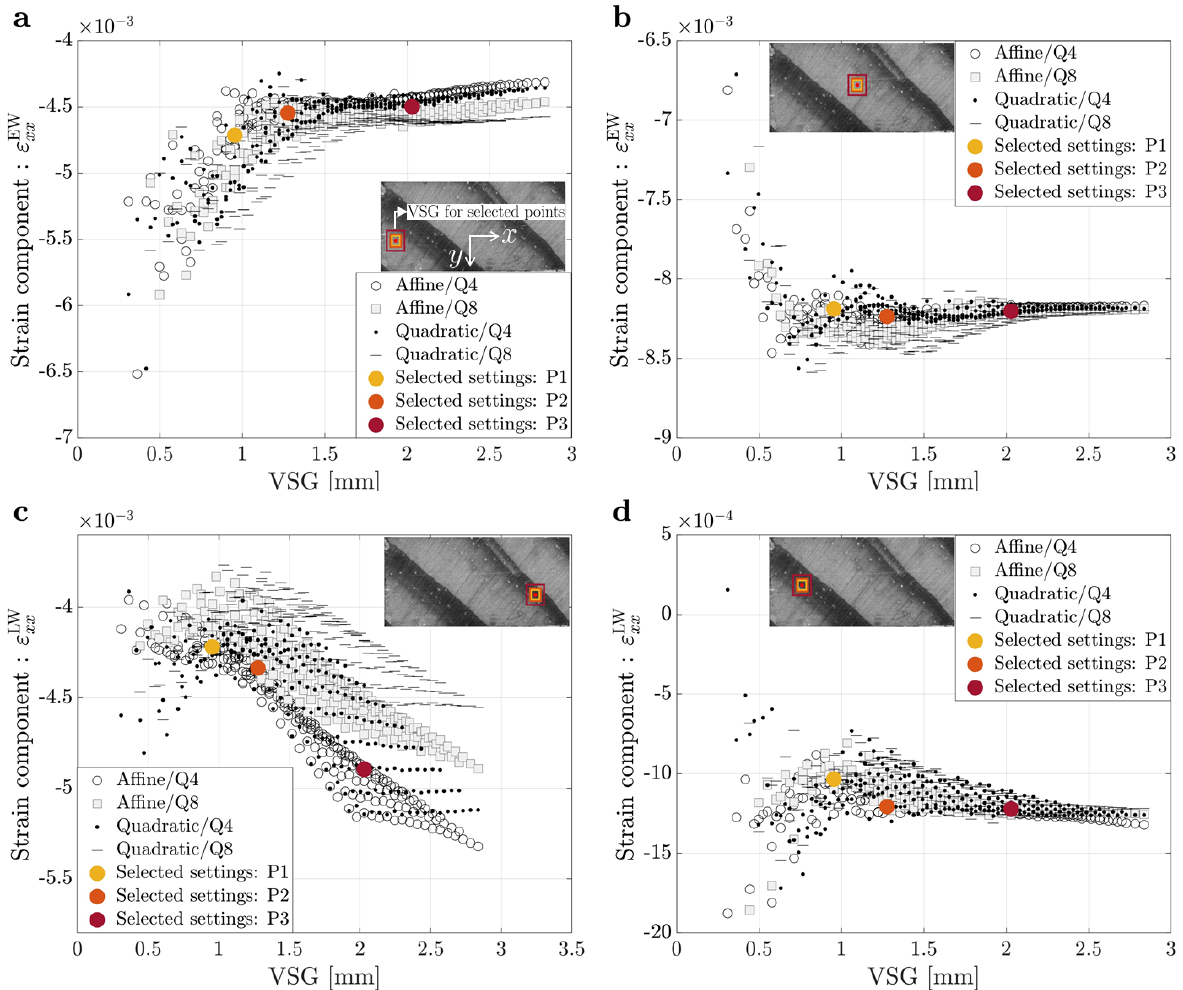
Figure 4. Signal versus virtual strain gauge for an off-axis specimen for different points from the ROI: ( a ) Small earlywood (EW) tissue; ( b ) Large earlywood (EW) tissue; ( c ) Small latewood (LW) tissue and ( d ) Large latewood (LW)